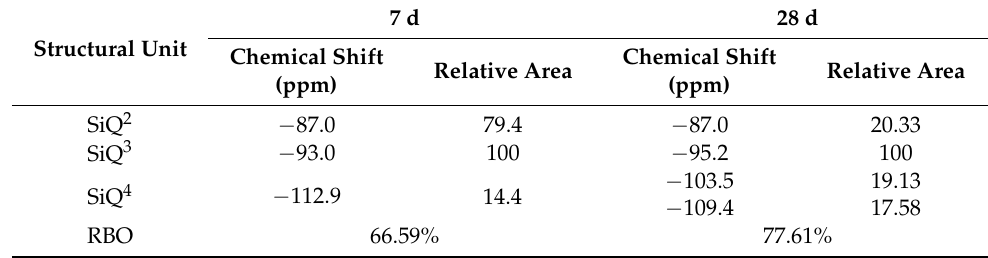
Table 3. RBO calculation results of C-A-S-H gels of AACM hydrated for 7 and 28